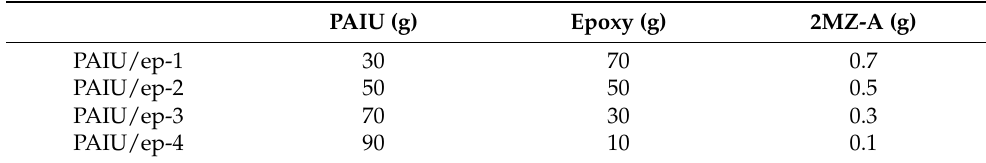
Table 1. Compositions of PAIU/epoxy